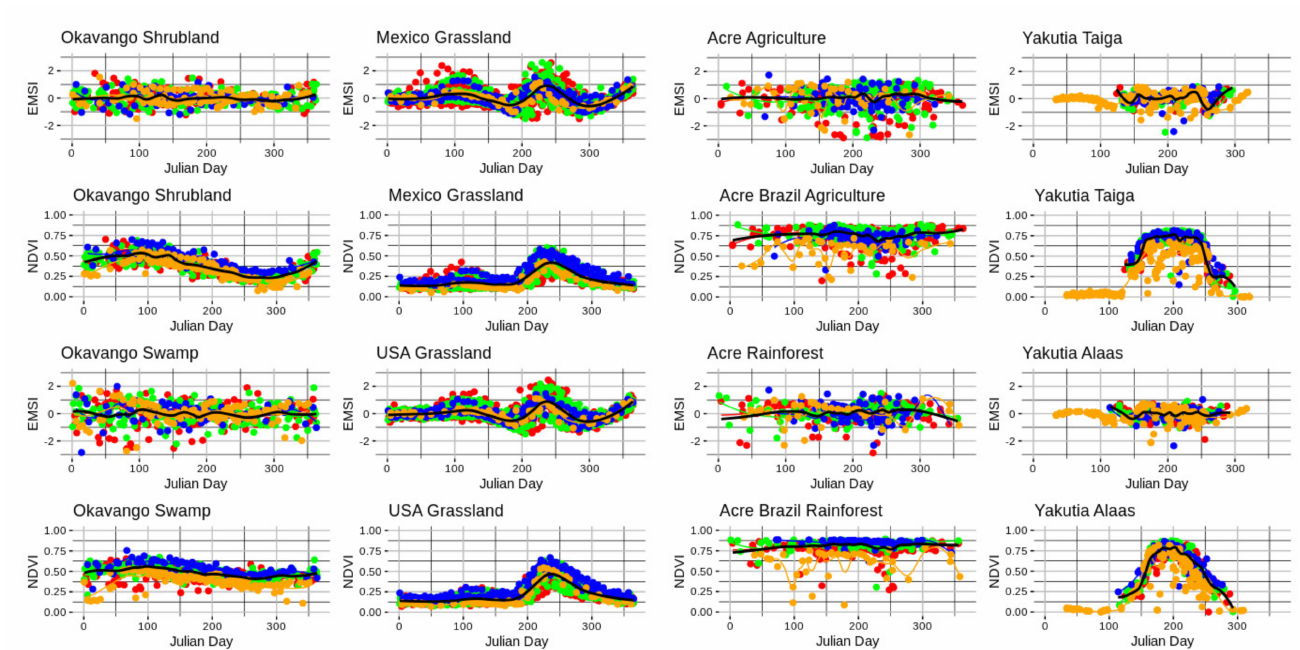
Figure A1. NDVI and EMSI Julian time series from Landsat 5, 7, 8 and Sentinal-2, for the eight example locations. The black line shows the long-term moving average of Landsat. The color scheme uses the same palette as Figure 5 in the main text.